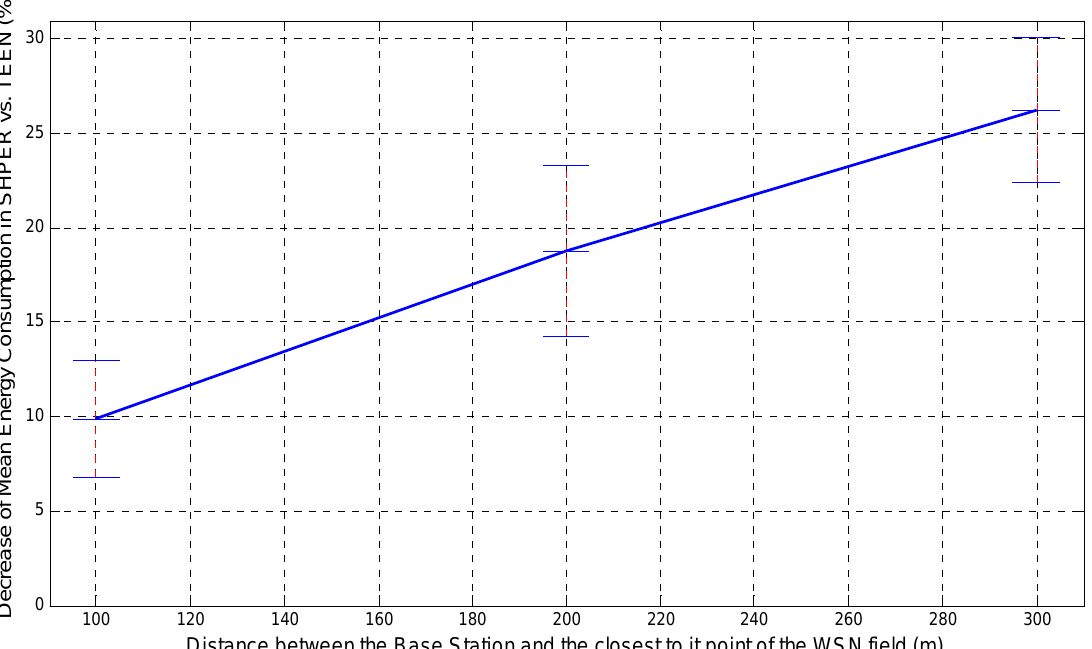
Figure 15. Percentage of average decrease of energy consumption in SHPER opposed to TEEN over the distance of the base station from the WSN field ( Er